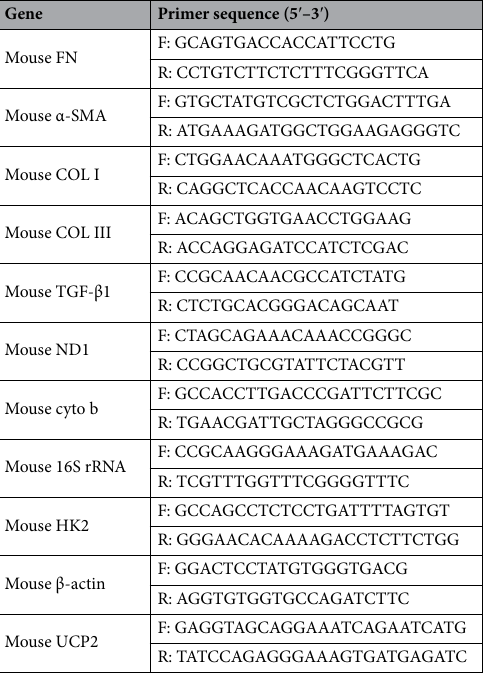
Table 1. Sequences of the primers for